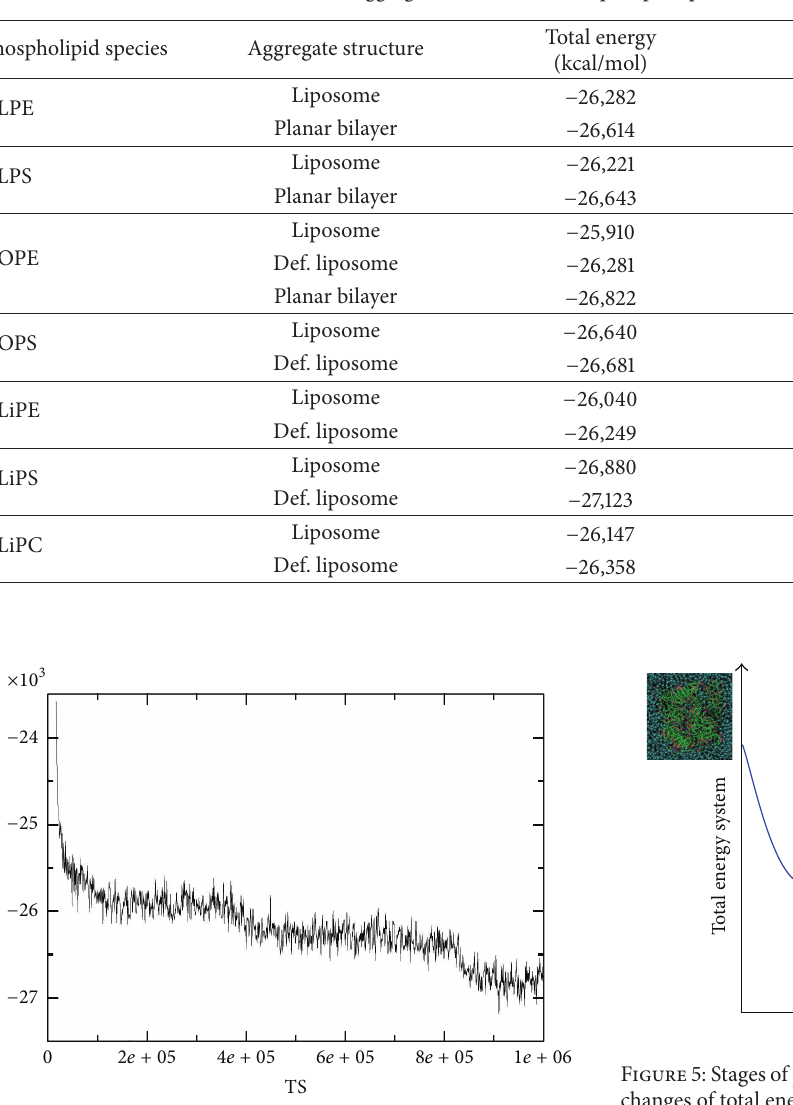
Figure 4: The total energy profile of 256 DOPE molecules during 160ns of simulation.